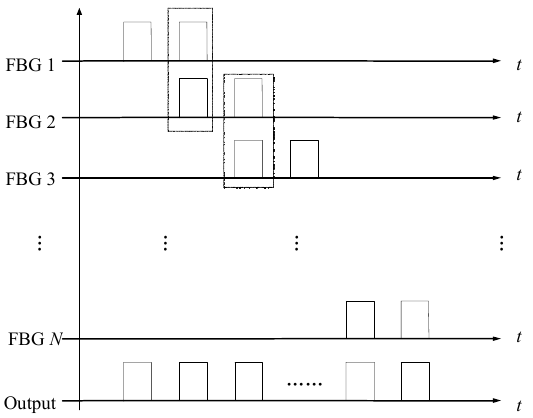
Fig. 2 Principle diagram of fiber Bragg grating array reflected light